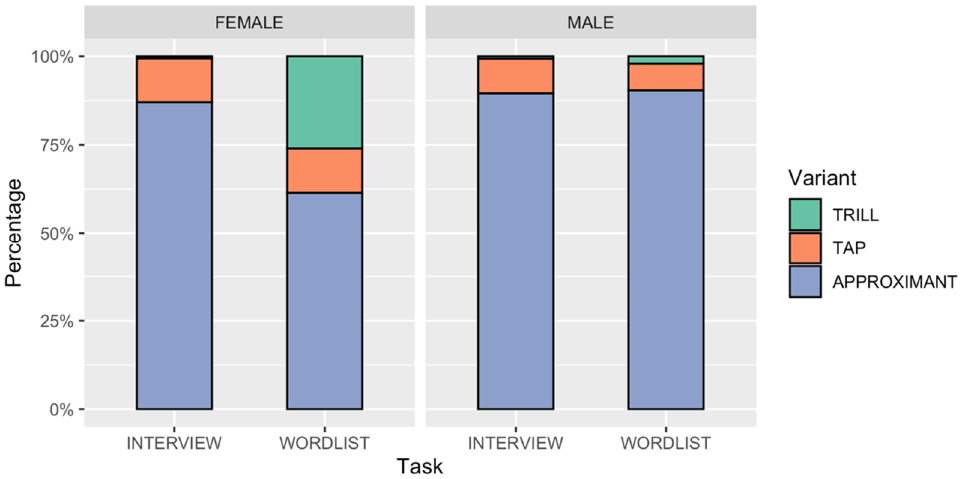
Figure 2. Distribution of /r/ variants in the Caernarfon English-language subset by speaker gender and task ( n = 764).